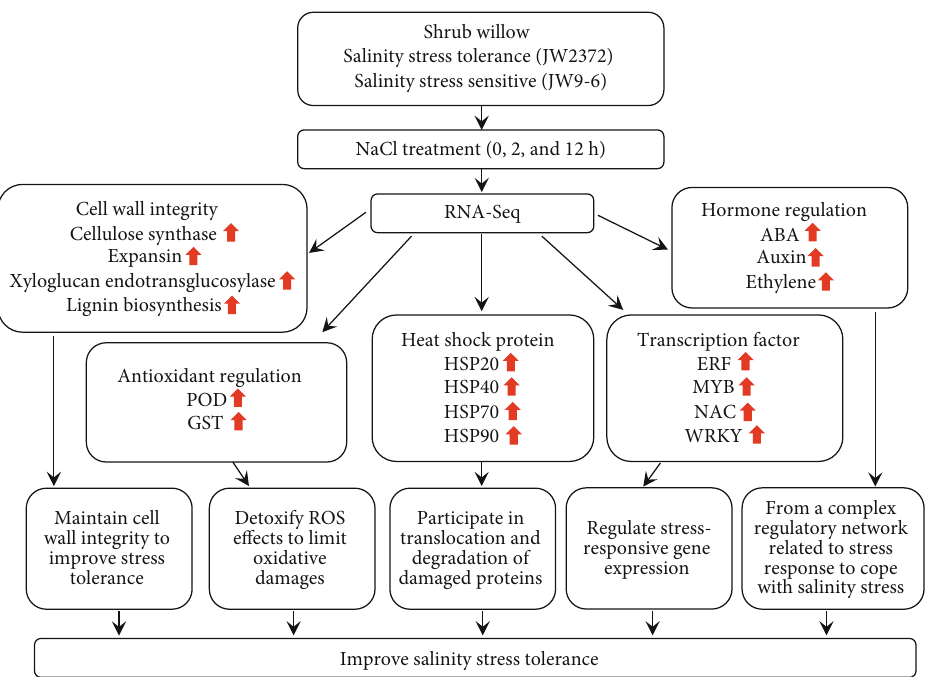
Figure 7: A schematic complex regulatory mechanism of salinity stress tolerance in shrub willow. Upon exposure to salinity stress, genes involved in cell wall integrity, antioxidant regulation, heat shock protein, hormone regulation, and transcription factor were upregulated in shrub willow. Red arrows represent upregulated genes. POD: peroxidase; GST: glutathione S-transferase; ABA: abscisic acid; HSP: heat shock